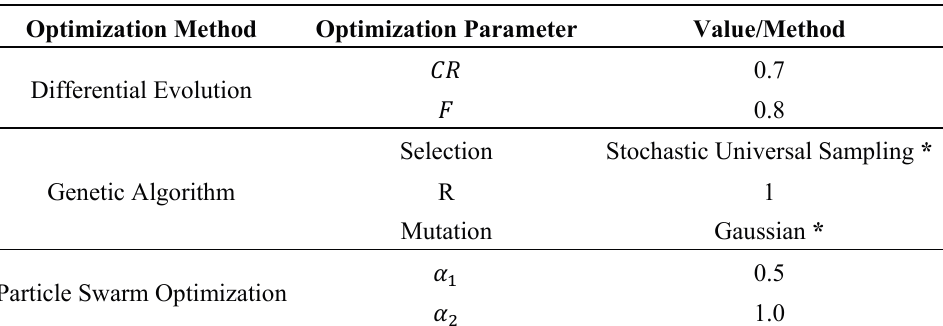
Table 5. Optimization methods parameters.